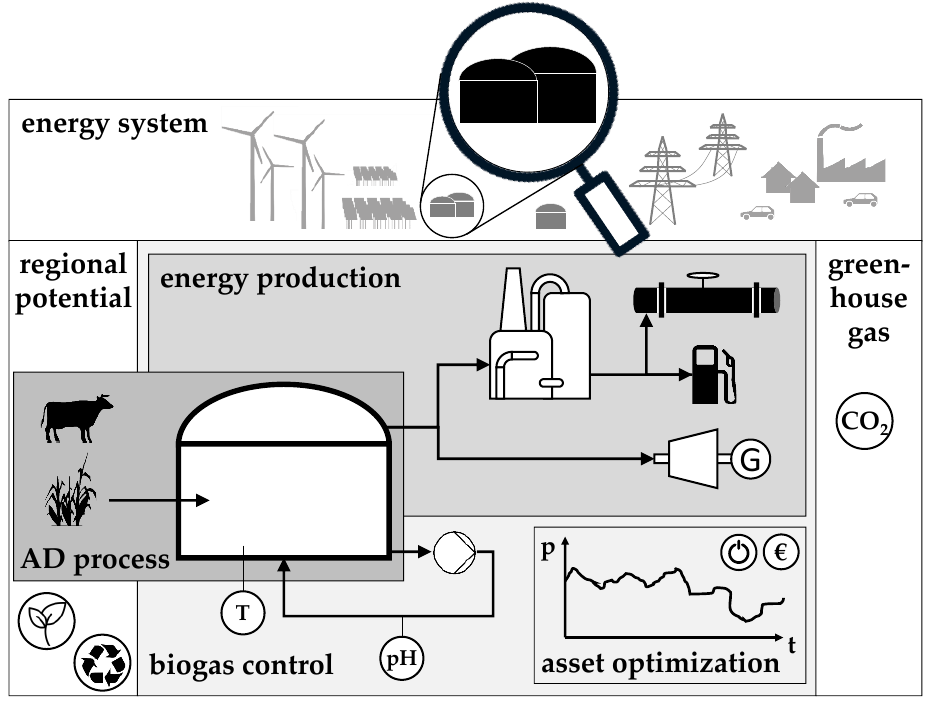
Figure 1. System boundaries for different views on biogas plants.